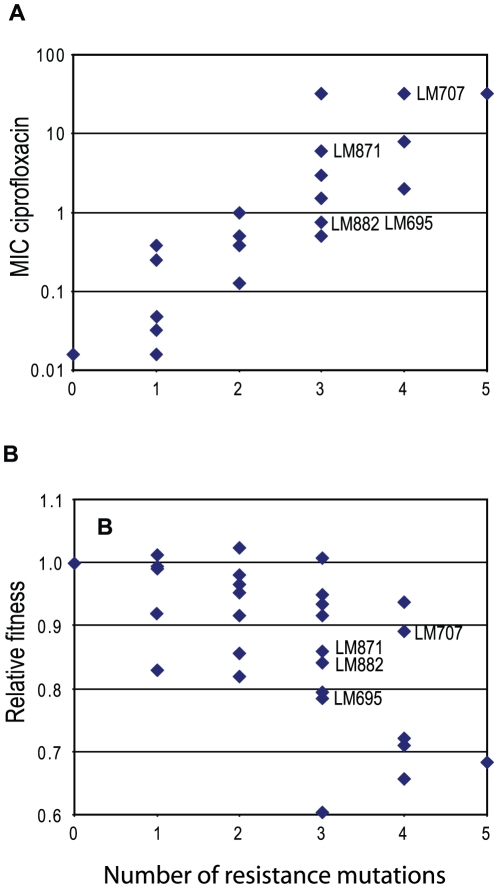
Resistance and fitness of constructed strains.For the wild-type and each of the 28 constructed isogenic strains the MIC for ciprofloxacin (part A) and the relative fitness per generation in in vitro growth competition (part B) is shown as a function of the number of resistance mutations per strain. Each diamond symbol represents one strain. In some cases more than one symbol occupies the same space. Strain identification numbers are shown for four strains of particular interest (Table 2).